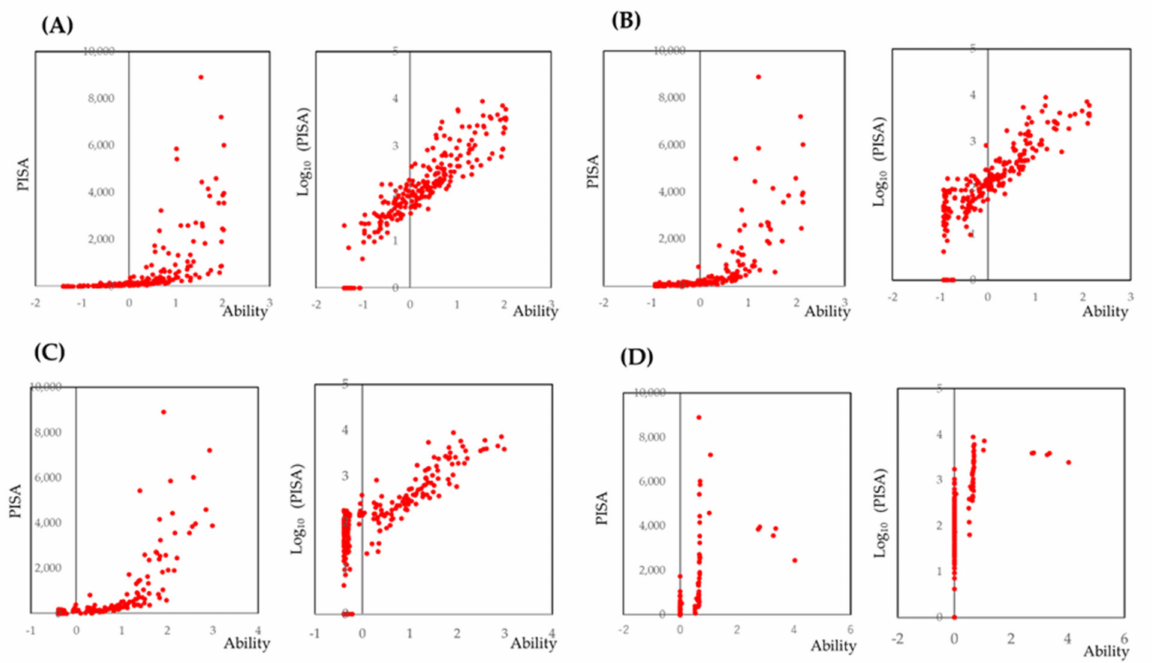
Figure 1. Scatter plots of PISA against the number of bleeding sites within each tooth. ( A – D ) Scheme 1. 2, 3, and 4 bleeding sites within each tooth. Ability, which indicates the weighted sum of the number of sites with bleeding on probing, was calculated by the three-parameter logistic model based on item response theory analysis. When PISA was log 10 transformed, linear relationships were